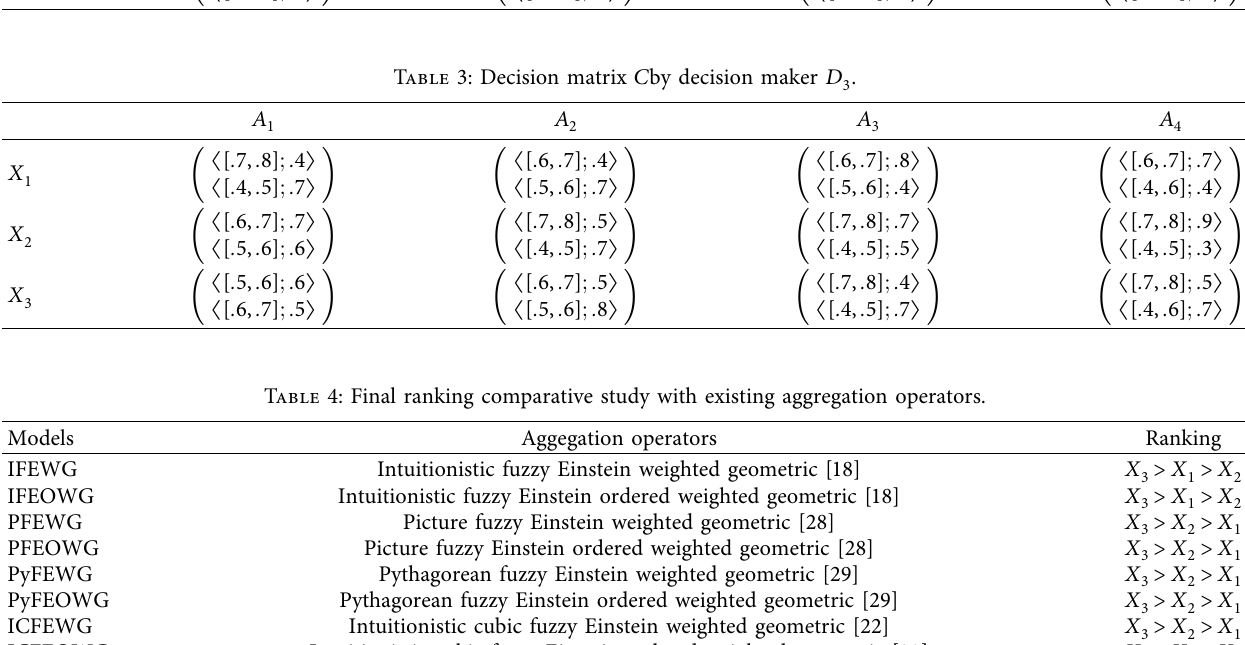
Table 3: Decision matrix C by decision maker D